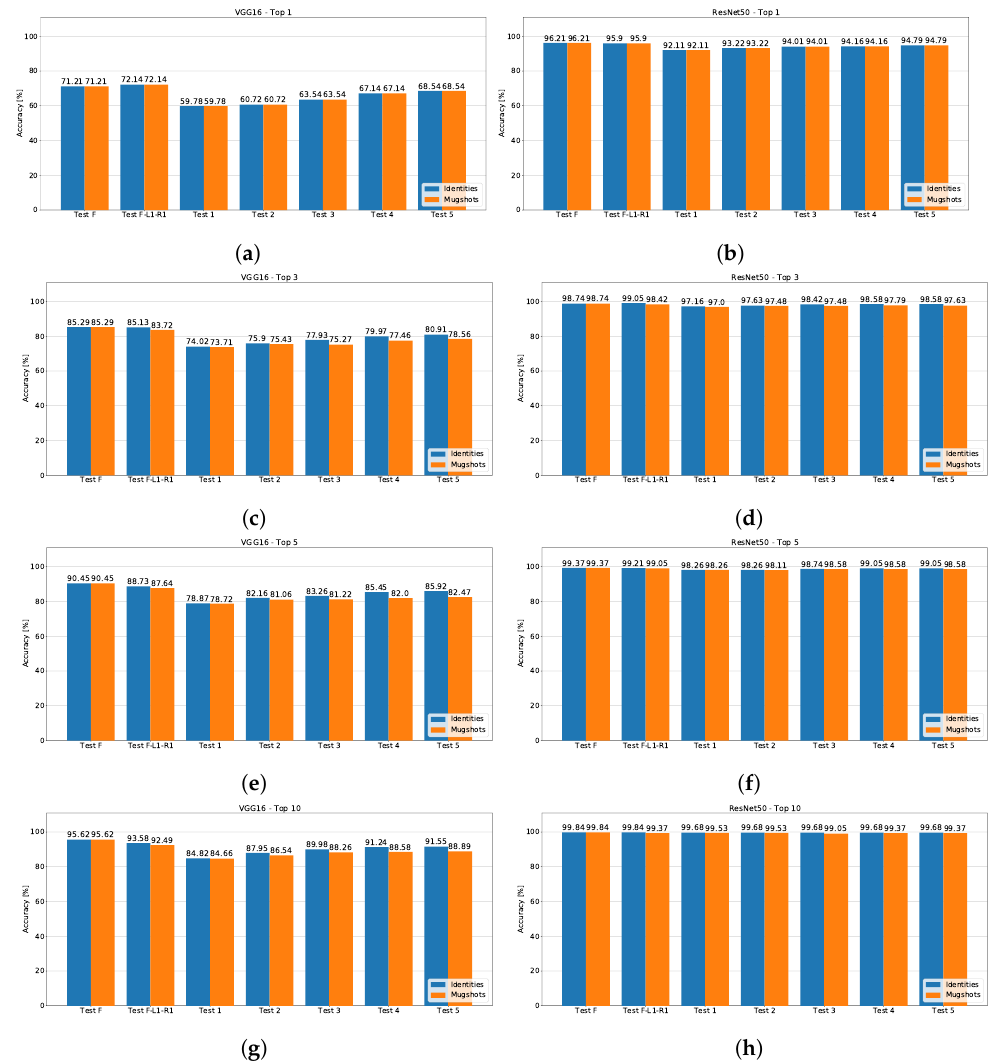
Figure 5. Accuracy measures for ResNet50 (right) and VGG16 (left) on the SCFace database. The charts include the Top-1 ( a , b ), top-3 ( c , d ), top-5 ( e , f ), and top-10 ( g , h ) rankings, in terms of nearest identities (blue) and mugshots